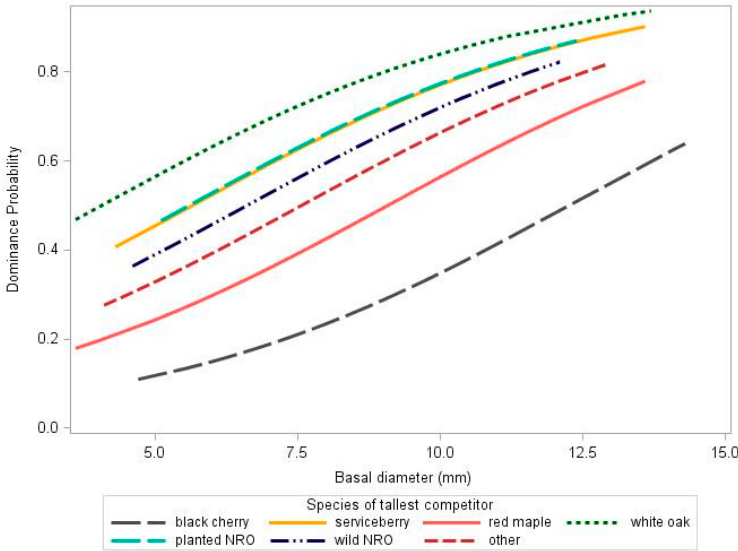
Figure 7. Regression model using basal diameter at planting and species of tallest competing stem to predict eleventh-year dominance probability. NRO stands for northern red oak.